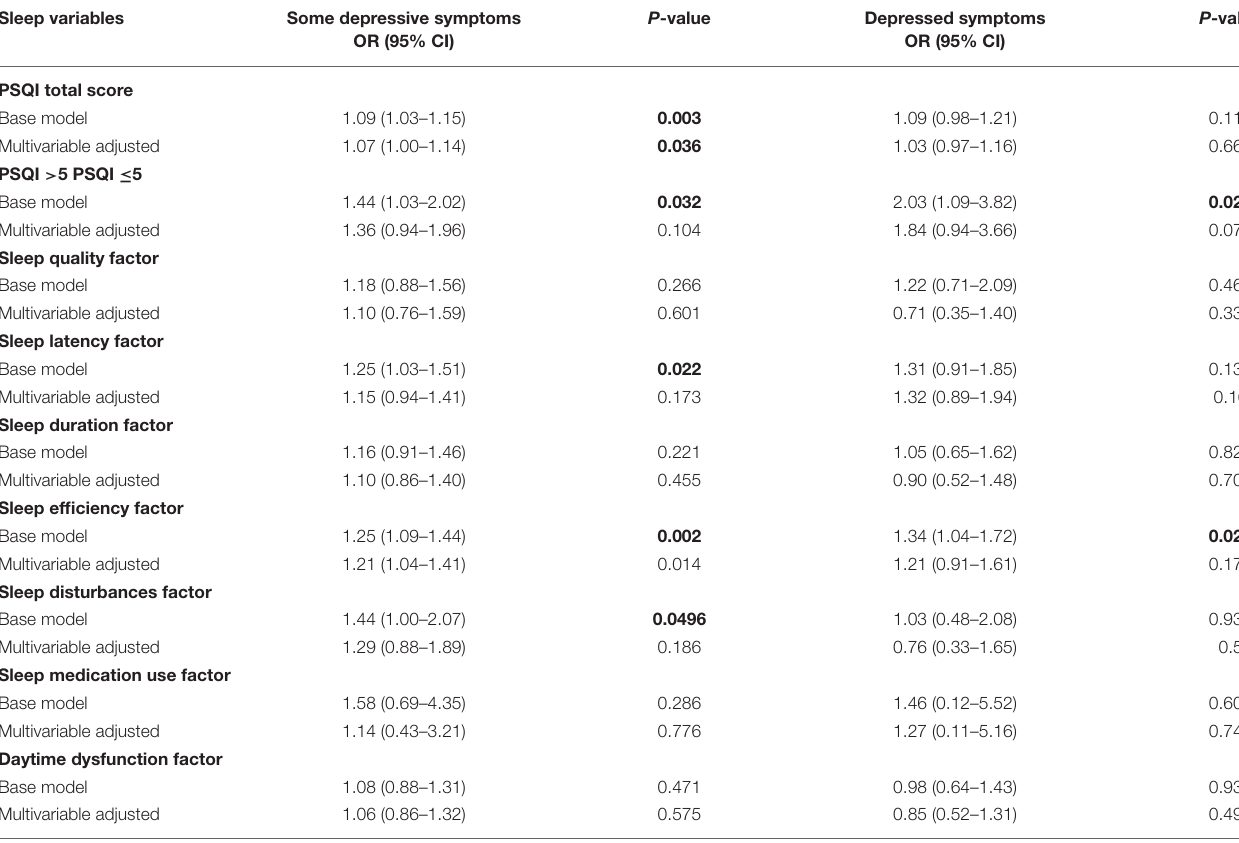
TABLE 3 | Associations between sleep disturbance at baseline and depressive symptom level at the 3-year follow-up. Sleep variables